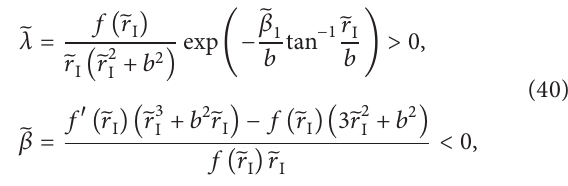
̃ℎ 󸀠 (𝑟) = ̃𝜆(3𝑟 2 + ̃𝛽𝑟 + 𝑏 2 ) ̃𝛽 < 𝛽 𝜆 < ̃𝜆 < 𝜆 𝛽 < ̃𝛽 < 𝛽 𝜆 < 𝜆 < ̃𝜆 ), 2 , 2 1 ) and ( 1 2 , 2 1